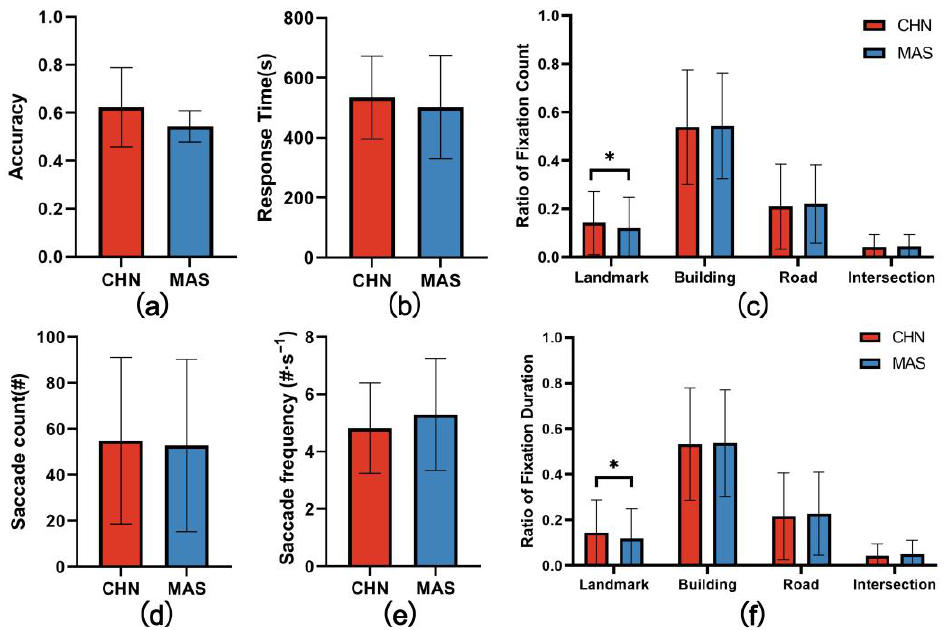
Figure 6. Statistics in the spatial orientation task: ( a ) accuracy; ( b ) response time; ( c ) ratio of fixation count; ( d ) saccade count; ( e ) saccade frequency; ( f ) ratio of fixation duration (* p < 0.05, ** p < 0.01).